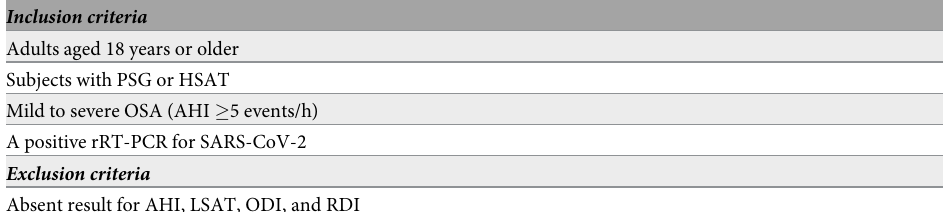
Table 1. Inclusion criteria for the selected study